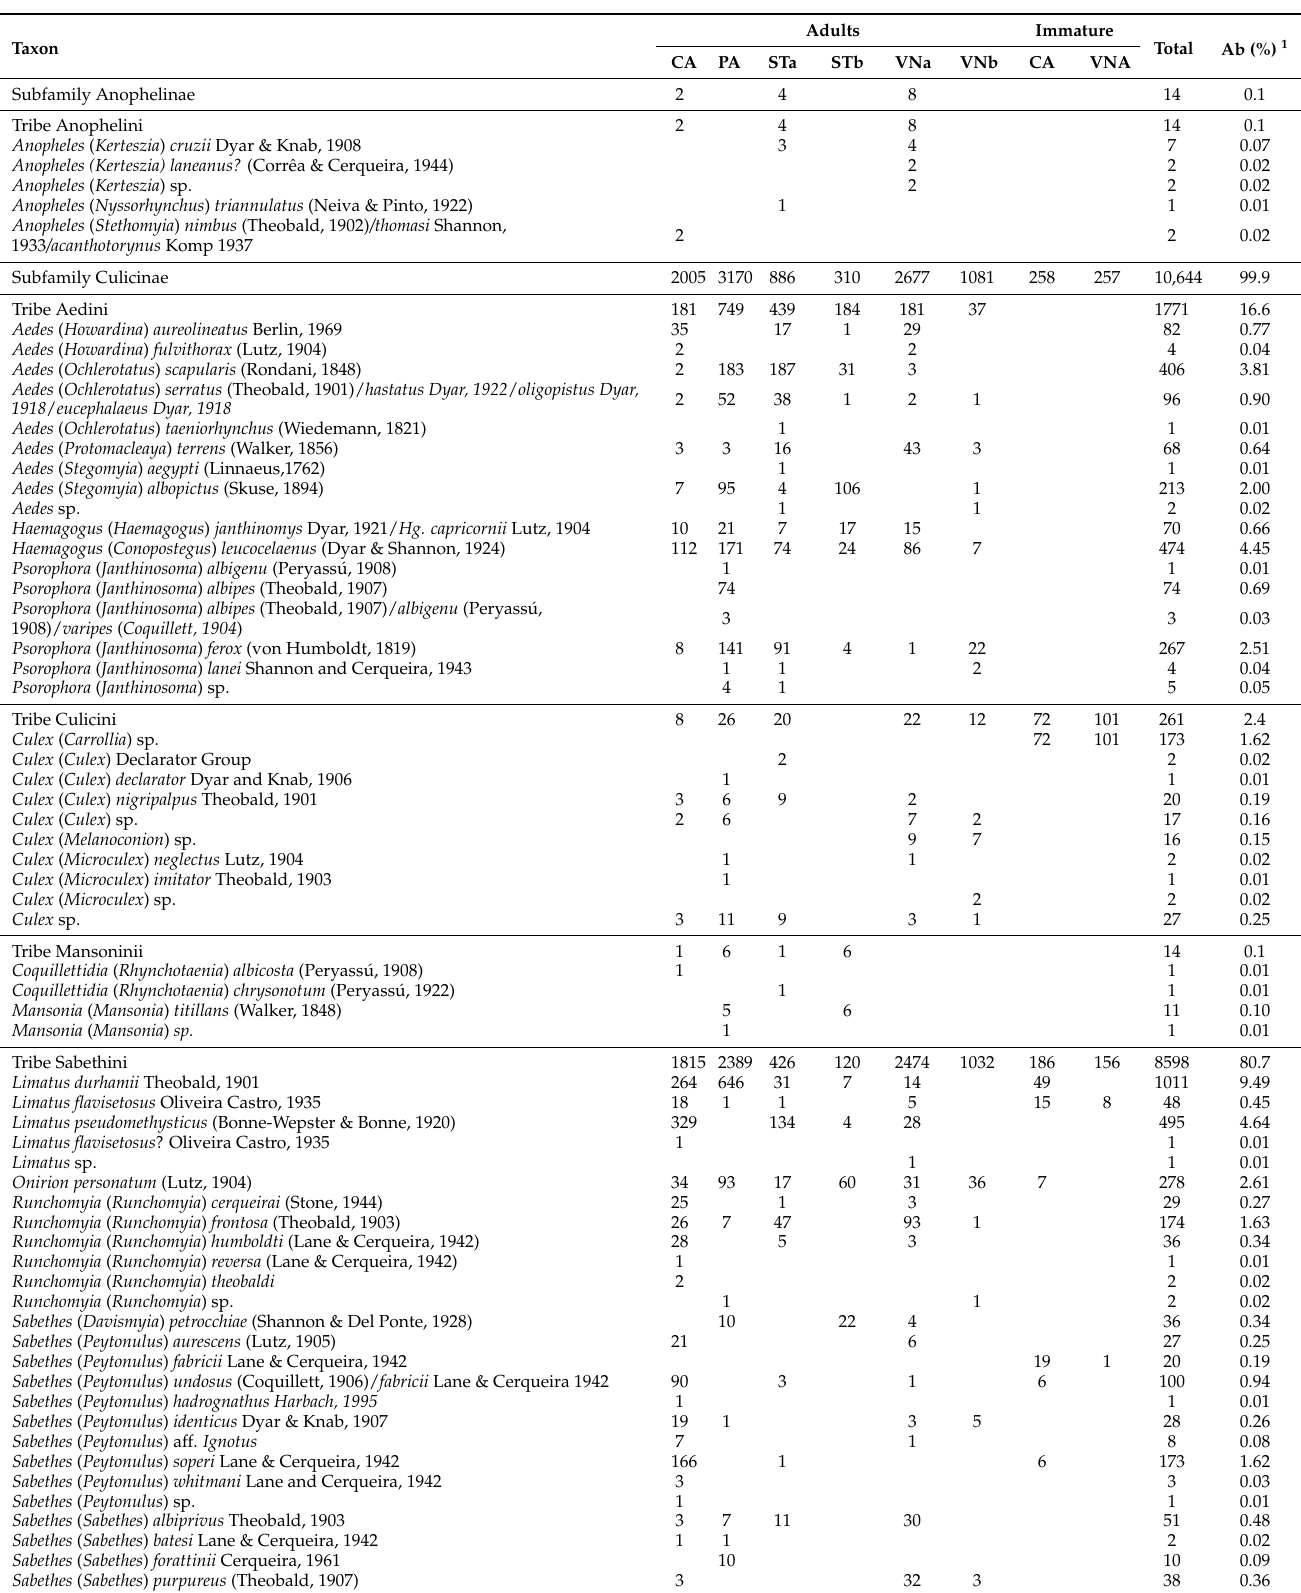
Table 1. Mosquito species identified at the six study sites located in four municipalities of Esp í rito Santo, including Cariacica (CA), Pancas (PA), Venda Nova do Imigrante (VNa and VNb), and Santa Teresa (STa and STb), from February to June